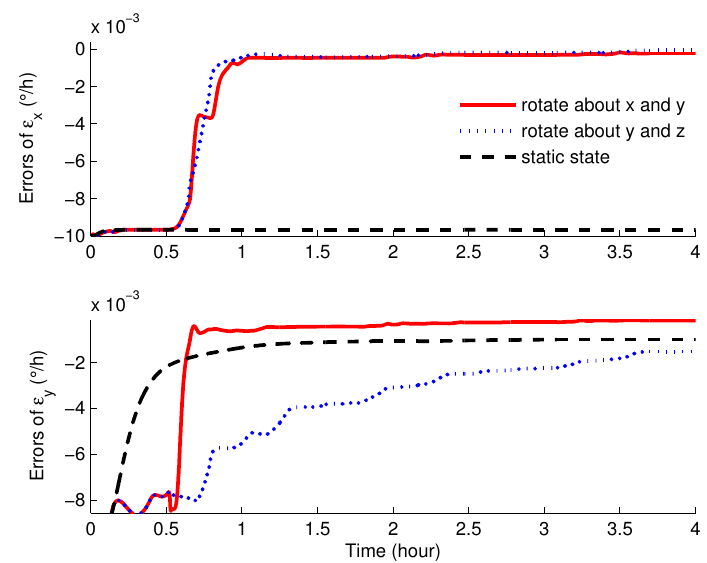
Figure 7. The estimated errors of the horizontal gyroscope drifts of the rotation and static simulations.